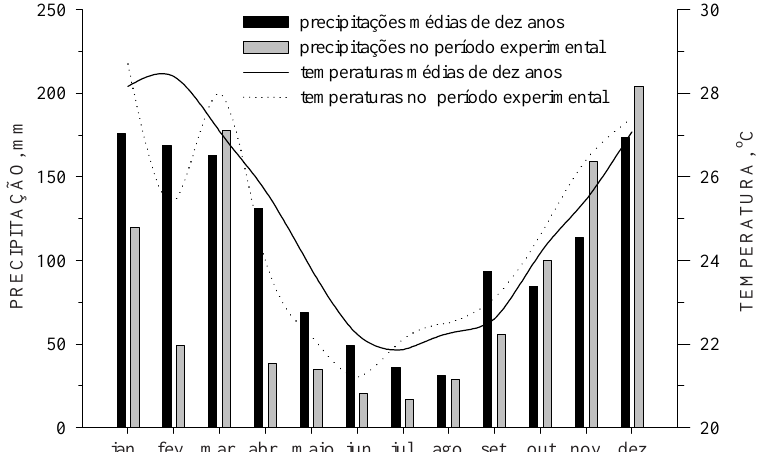
Figura 1. Variação mensal das precipitações e temperaturas no período de estudo e as médias dos últimos dez anos. Dados obtidos na Estação Experimental de Itaguaí, Pesagro Ecologia, distante a, aproximadamente, 2 km da área de